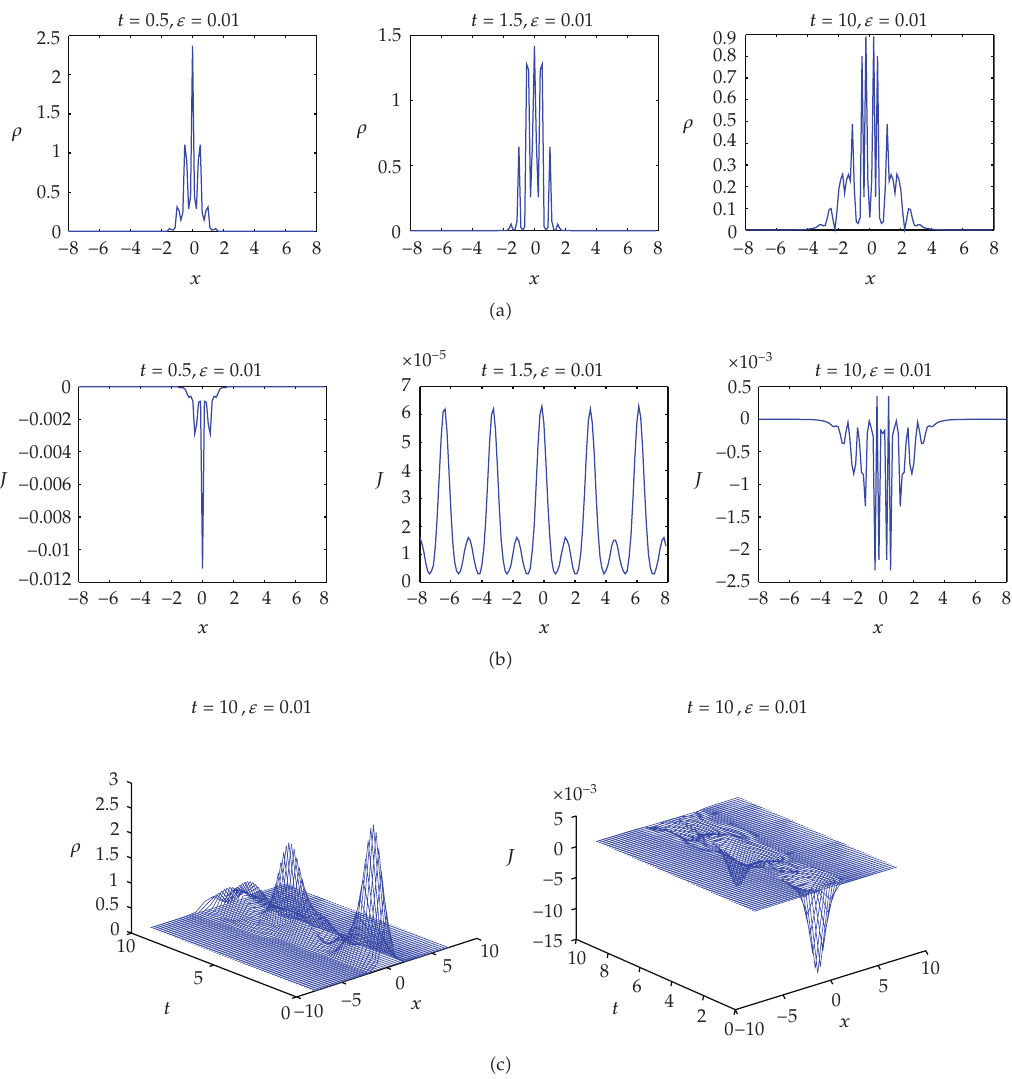
Figure 3: Numerical solutions of Example 5.1 by ED2/EP2 for the weak O (cid:3) ε (cid:4) defocusing nonlinearity (cid:3) ε (cid:6) 0 . 01 (cid:4) . (cid:3) a (cid:4) Position density ρ at t (cid:6) 0 . 5 (cid:3) before breaking (cid:4) , at t (cid:6) 1 . 5 (cid:3) after breaking (cid:4) , at t (cid:6) 10. (cid:3) b (cid:4) Current density J at t (cid:6) 0 . 5 (cid:3) before breaking (cid:4) , at t (cid:6) 1 . 5 (cid:3) after breaking (cid:4) , at t (cid:6) 10. (cid:3) c (cid:4) Evolution of the position density ρ (cid:3) left (cid:4) and the current density J (cid:3) right (cid:4) .